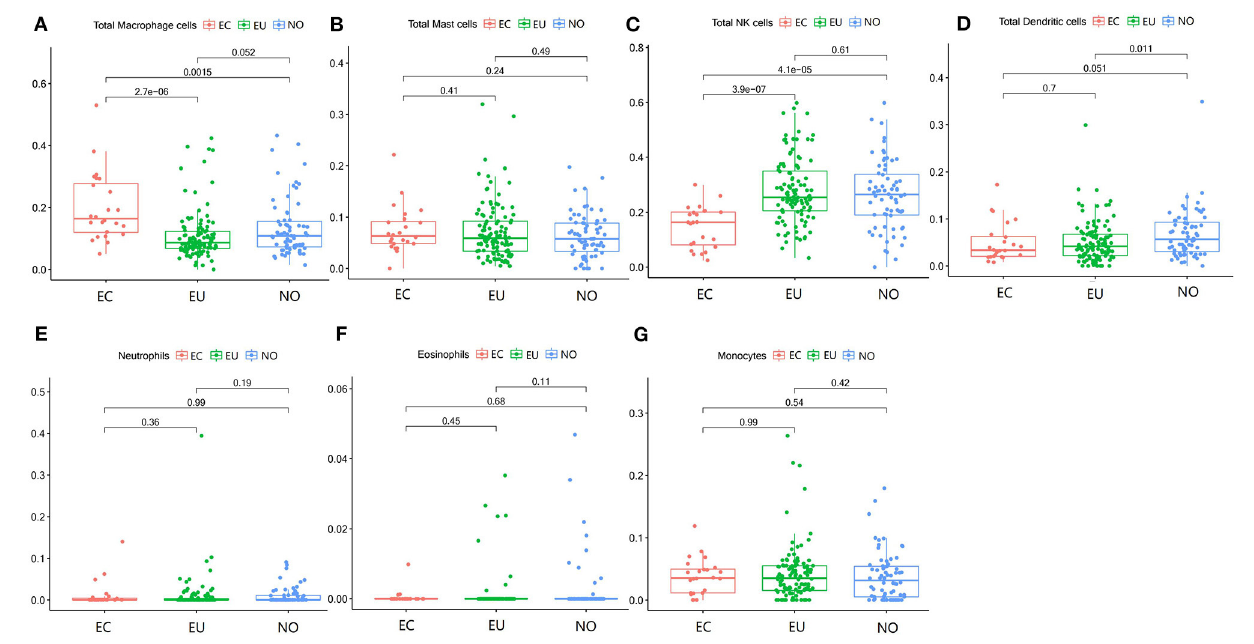
Frontiers in Genetics |